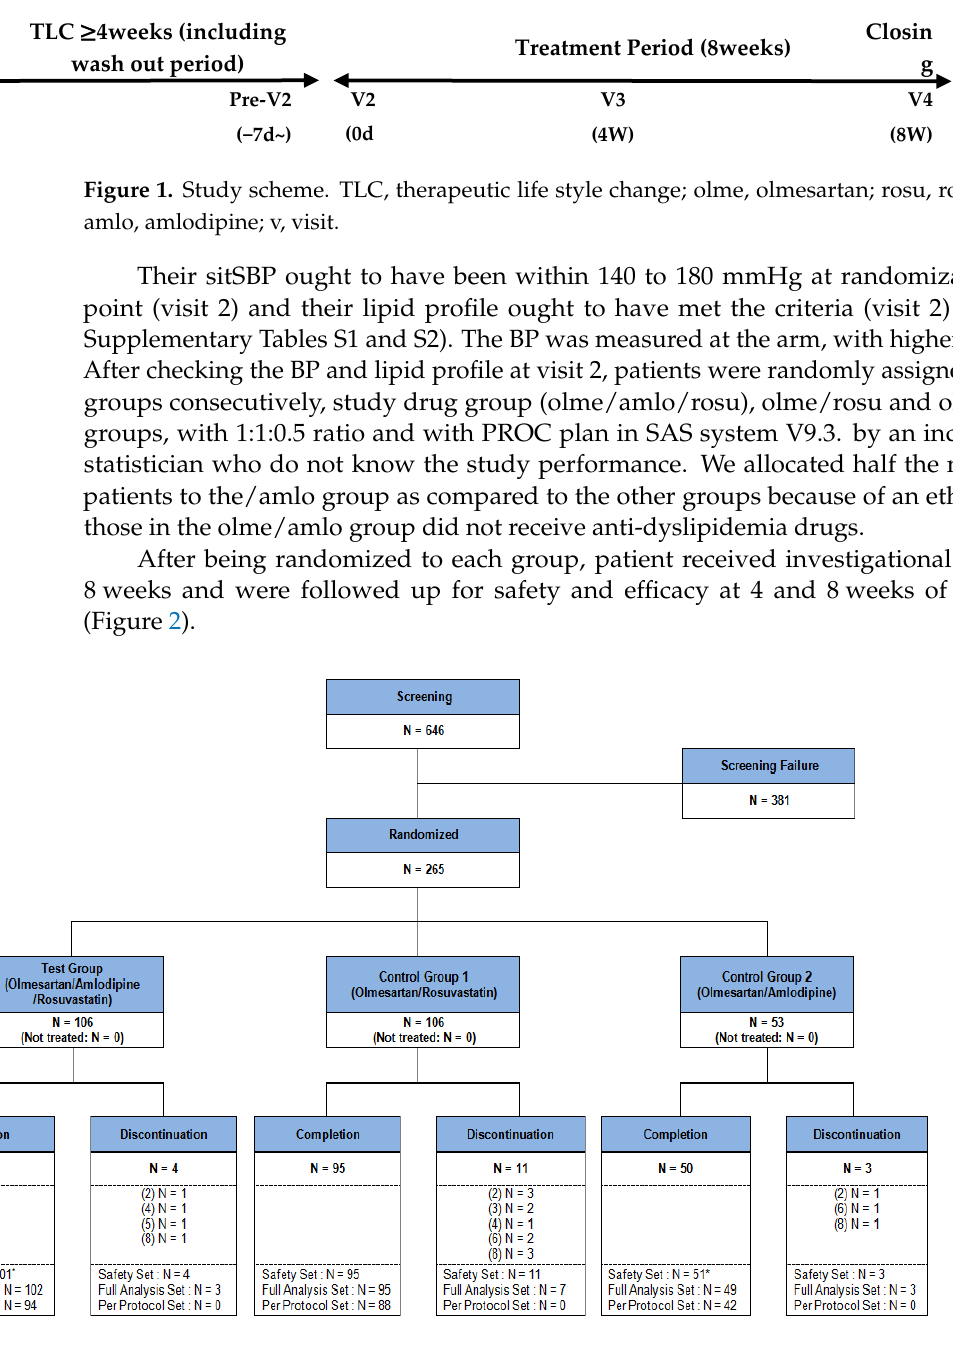
Figure 2. Study patients flow. * = 1 person was classified into olme/amlo group instead of olme/amlo/rosu group in safety analysis due to study investigational product was falsely distributed.